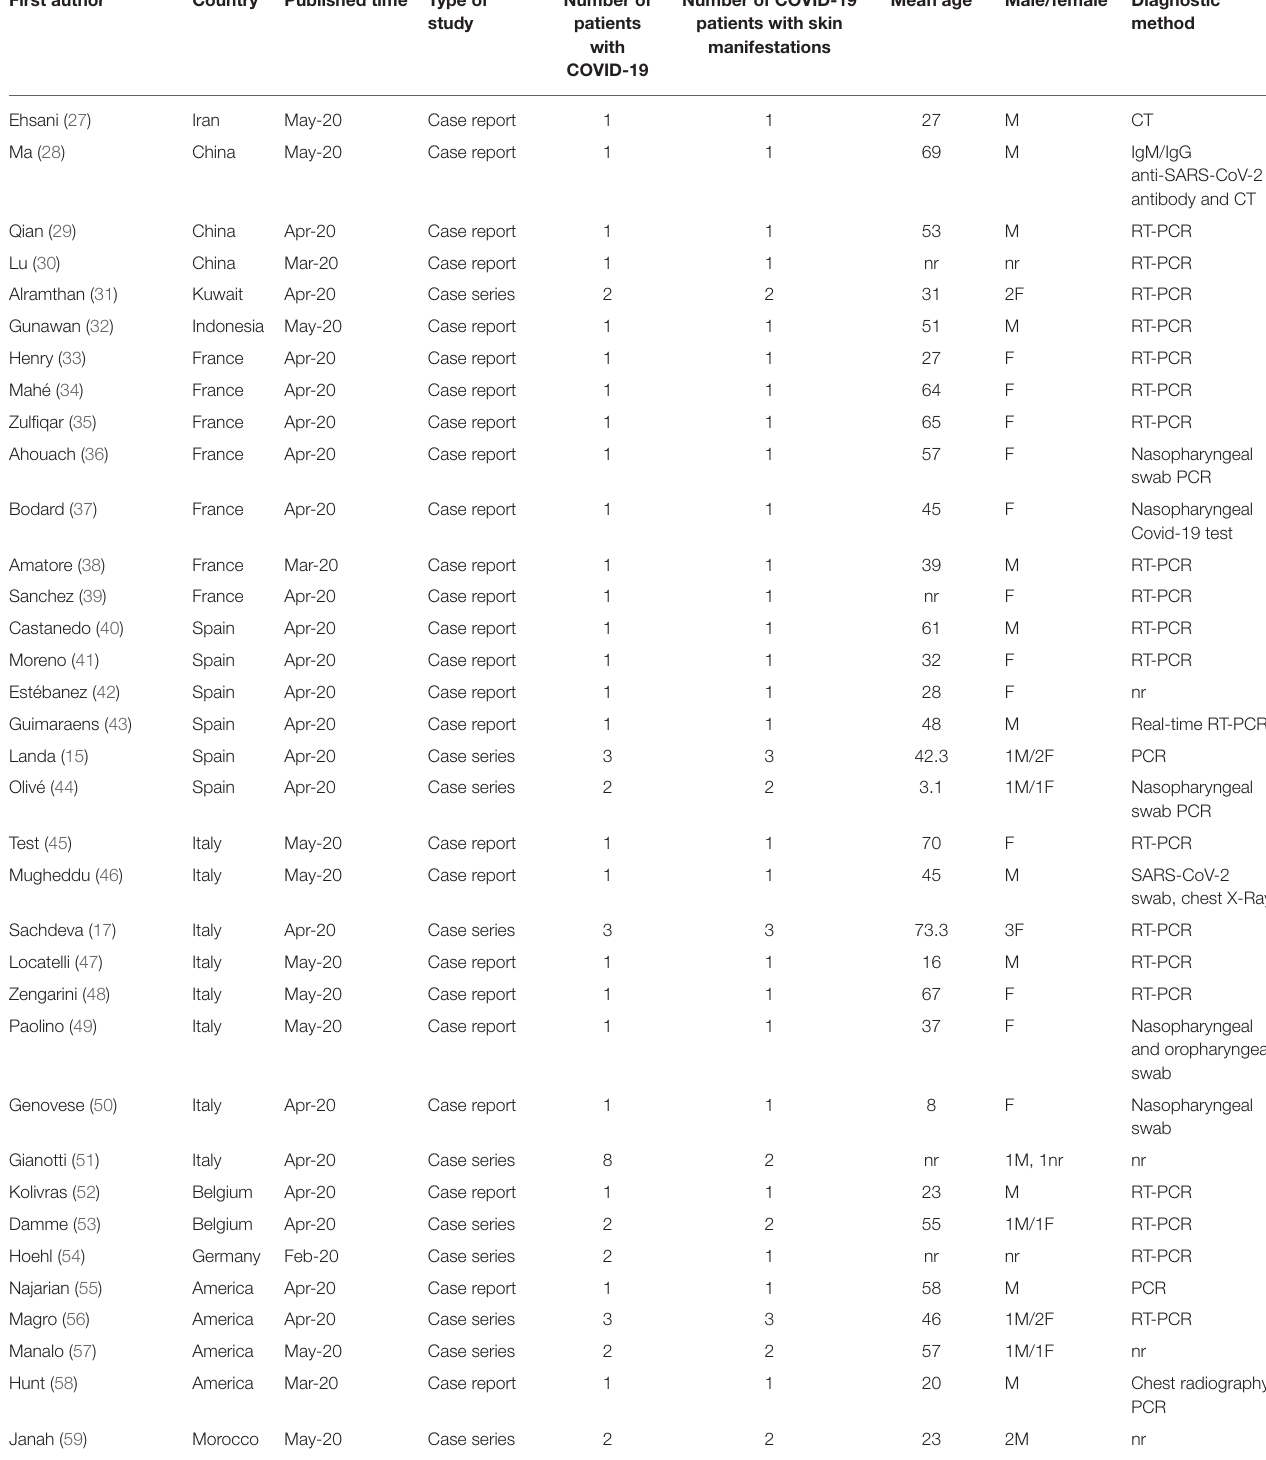
TABLE 2 | Characteristics of Case reports/case series